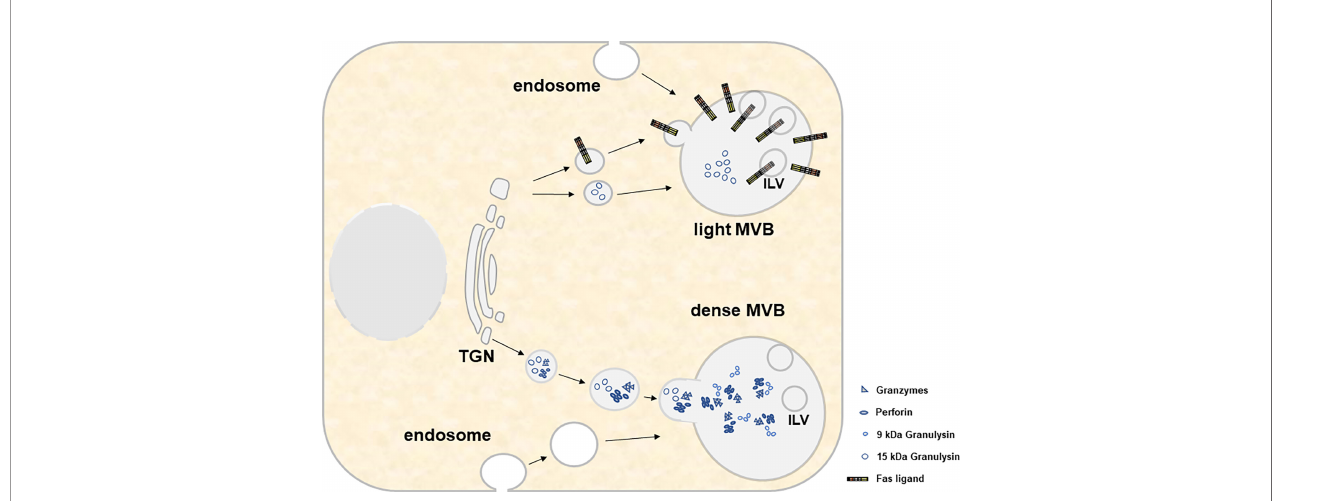
FIGURE 2 | For both light and heavy MVBs, cytotoxic effector molecules and other constituent soluble proteins are transported from the trans-Golgi network. This transport involves several compartments, fusion events and organelle maturation steps that are not displayed in the present cartoon. Material transfer to MVBs involves transitory transport vesicles, early and late endosomes, recycling endosomes and/or endolysosomes/lysosomes. Moreover, it includes several maturation events such as the decrease of the pH, the formation of intraluminal vesicles (ILV) and the accumulation of cytolytic effector proteins within electron-dense cores. While light MVB are characterized by the presence of 15 kDa GNLY and FasL, dense MVB contain GRZs, PRF and 9 kDa